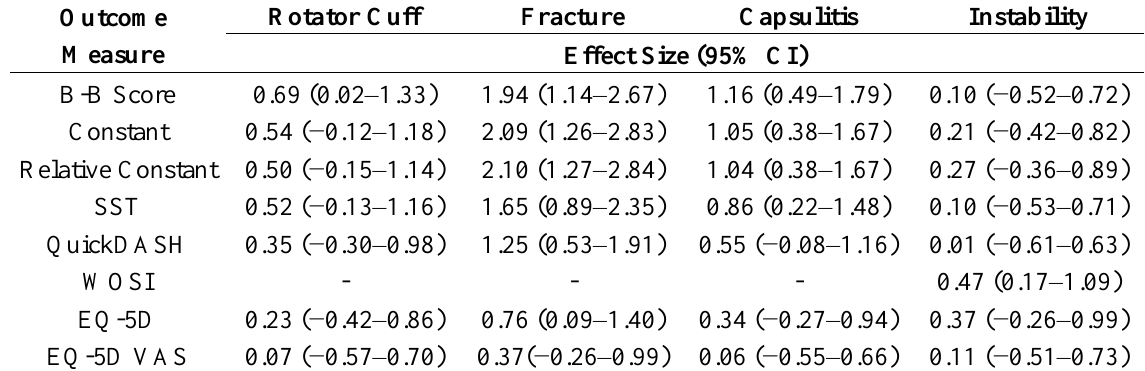
Table 3. Effect Size (95% CI) for each score and each